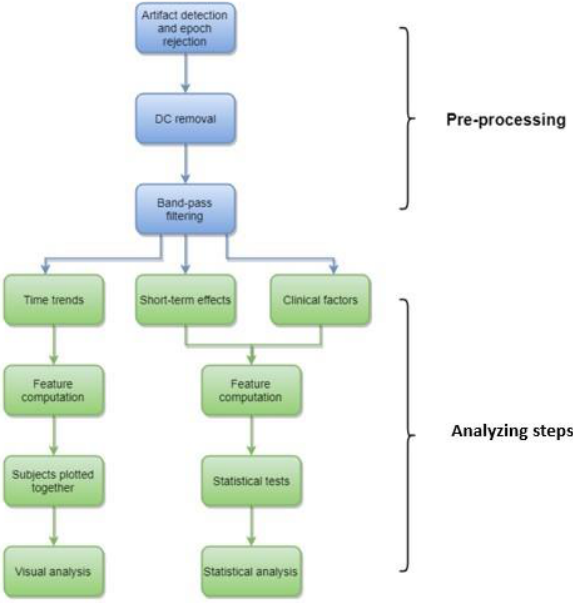
Figure 1. Study Figure 1. Study flowchart.